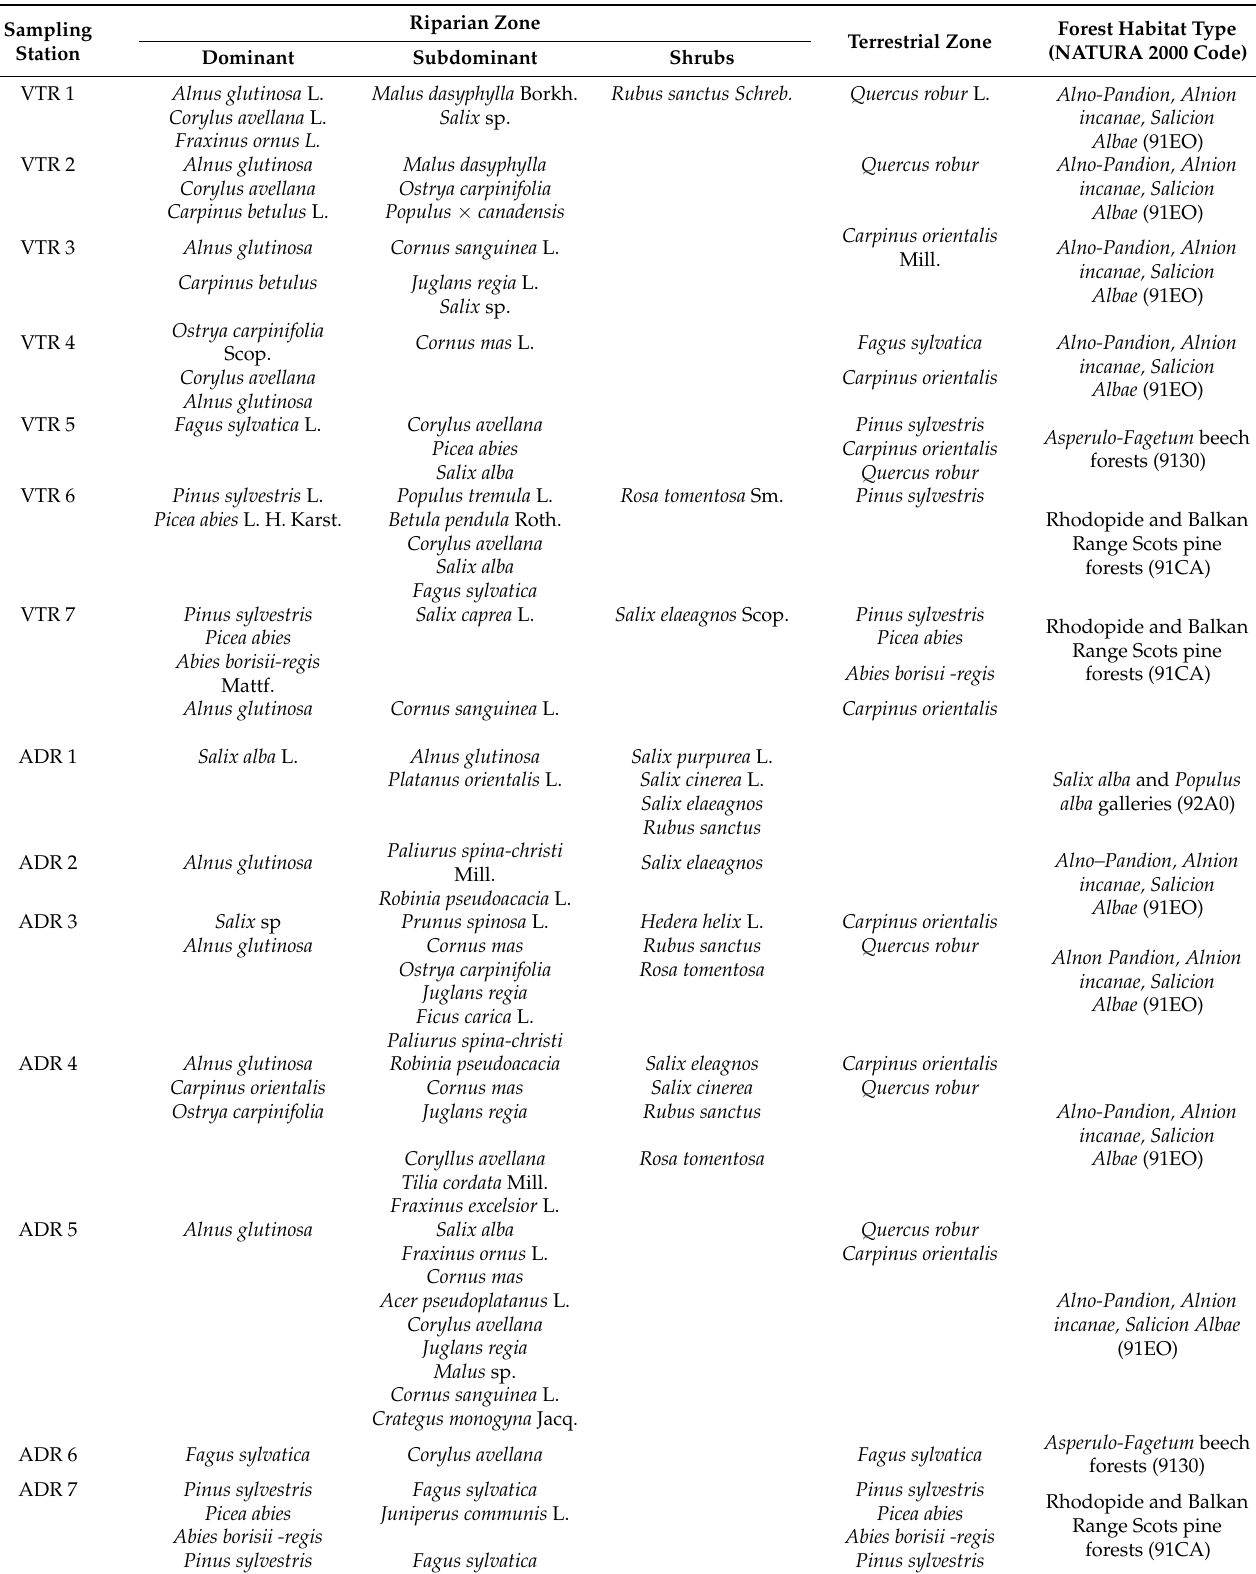
Table 4. The dominant and subdominant trees, shrubs and forest habitat types of the riparian zone at each station. In addition, the dominant tree species of the terrestrial zone are presented. Sampling